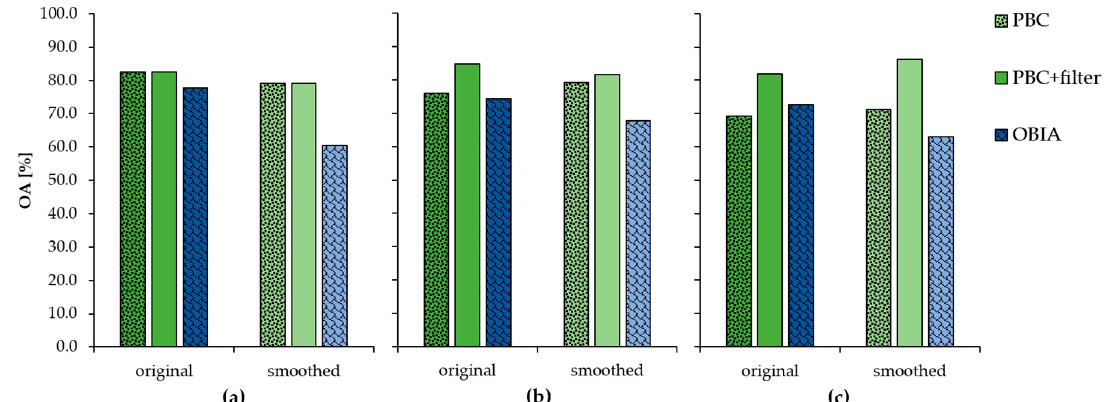
Figure 9. Overall accuracy (OA) of the classification maps obtained through the three semi-automatic classification methods tested in the study, i.e., the pixel-based classification (PBC), the PBC followed by map filtering and the object-based image analysis (OBIA). The accuracy values are reported for the classification of low-resolution ( a ), medium-resolution ( b ) and high-resolution ( c ) images and for both original and smoothed images.